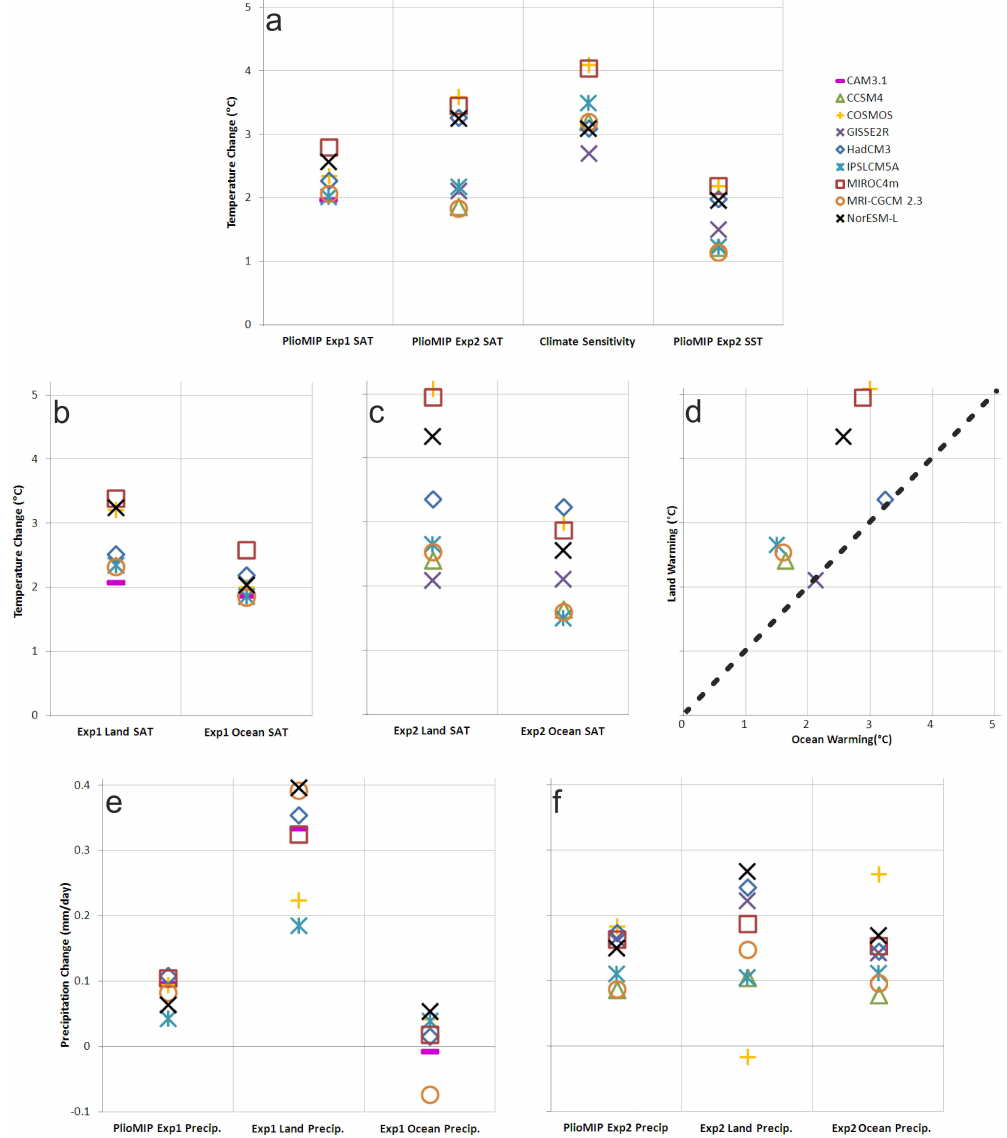
Fig. 1. (a) Global annual mean surface air temperature anomalies (mPWP minus pre-industrial control experiment) from each model in the PlioMIP Experiment 1 and 2 ensembles. Published estimates of Experiment 2 models’ equilibrium climate sensitivity also provided, alongside the global mean SST anomalies for each model in Experiment 2. Annual mean surface air temperature anomalies from each Experiment 1 (b) and Experiment 2 (c) simulation separated into response over land and oceans. (d) SAT warming over land against ocean SAT warming for all Experiment 2 simulations. Global, land and ocean annual mean total precipitation rate anomalies for all simulations from Experiment 1 (e) and Experiment 2 (f)